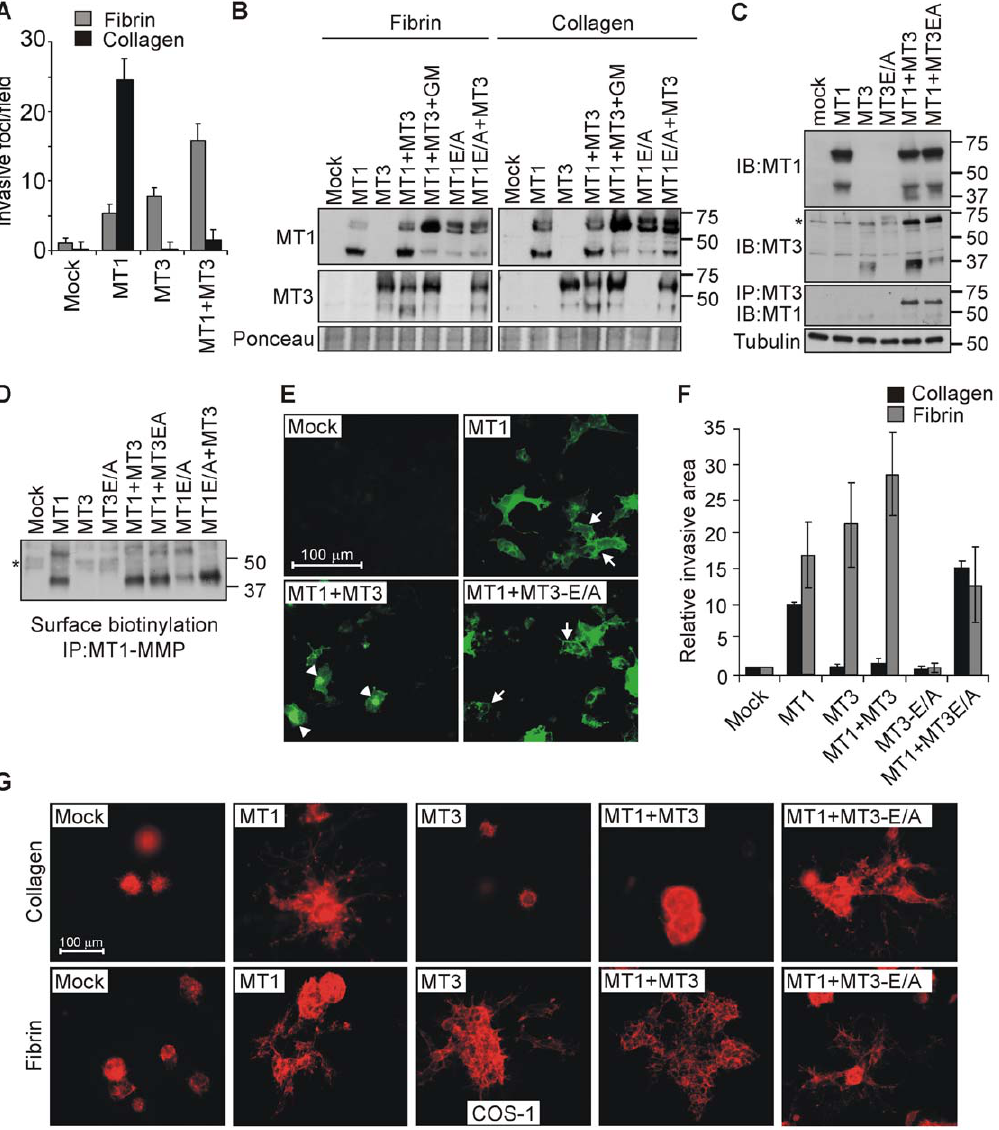
Figure 5. MT3-MMP regulates cell invasion in a matrix-composition dependent manner by driving fibrin invasion, while reducing the cell surface levels and collagen invasive activity of MT1-MMP. (A) COS-1 cells transiently transfected to express MT1-MMP (MT1), MT3- MMP (MT3), or both in combination, were allowed to invade 3D fibrin or collagen gels for 5 d. Quantitative results are expressed as the number of invasive foci per microscopic field (n=3). (B–C) MT1-MMP, inactive MT1-MMP (MT1E/A), MT3-MMP, and MT3E/A were expressed alone or in different combinations in COS-1 cells for 48 h followed by immunoblotting and immunoprecipitation as indicated. GM6001 (GM, 10 m M) was added where indicated. Ponceau-staining and tubulin served as loading controls (n=3). Asterix marks a non-specific band. (D) Cell surface MT1-MMP was detected from the transfected cells by surface biotinylation followed by immunoprecipitation. Asterix marks a non-specific band. (E) The transfected cells were fixed and stained for MT1-MMP with an antibody against its catalytic domain. Arrows indicate MT1-MMP staining on the cell surface in the cells expressing MT1-MMP alone or with inactive MT3E/A, as opposed to the perinuclear staining (arrowheads) in the cells co-expressing MT1-MMP and MT3-MMP. (F) The transfected cells were embedded in 3D collagen or fibrin as single cell suspension and allowed to grow for 5 d. Relative sizes of invasive areas per colony were calculated using ImageJ software (n=3). (G) Fluorescence micrographs visualize representative colonies of COS-1 cells cultured inside collagen or fibrin and stained for filamentous